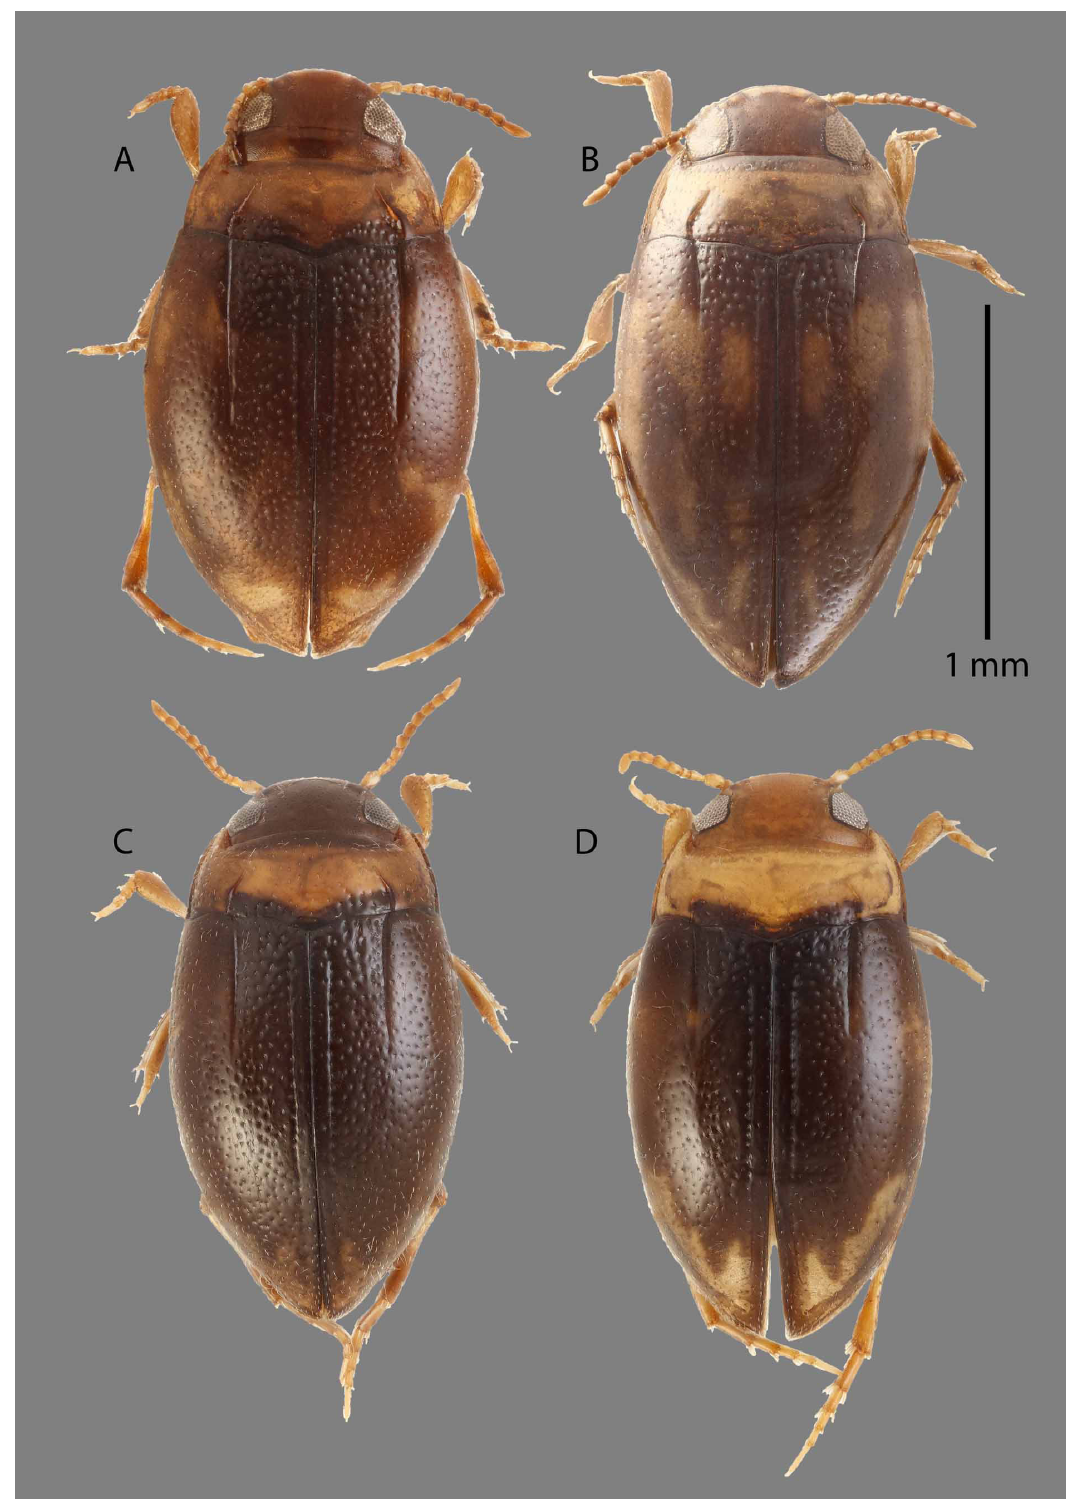
Fig. 1. Habitus photographs of Malagasy species of Bidessus Sharp, 1882. A . B . apicidens Biström & Sanfilippo, 1986, ♀, paratype, http://id.luomus.fi/GL.8408 (FMNH). B . B. cf. ceratus Guignot, 1941, http://id.luomus.fi/GC.2001 (FMNH). C . B. anjozorobe sp. nov., paratype (NHRS-JLKB000025034). D . B. cf. nero Gschwendtner, 1933